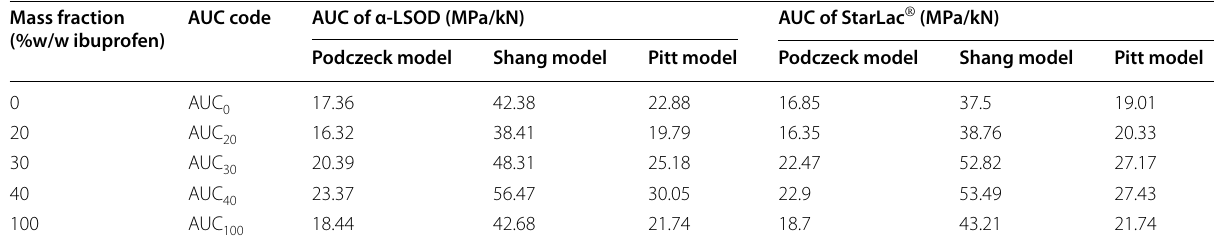
Table 3 Area under the tensile strength–compaction force profiles of the powder systems Mass fraction AUC code AUC of α‑LSOD (%w/w ibuprofen)